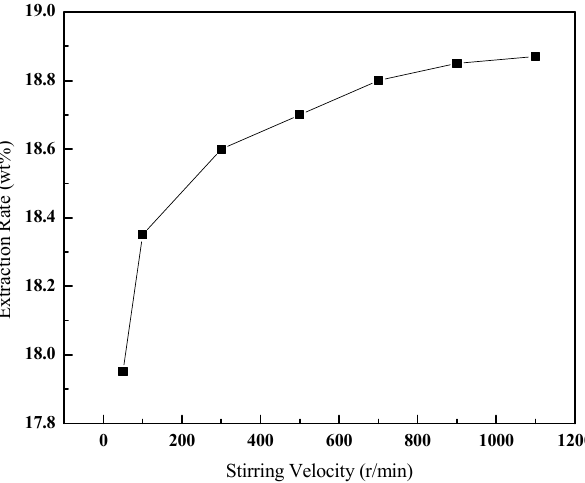
Figure 5. Effect of the stirring velocity on the extraction rate of Figure 5. E ff ect of the stirring velocity on the extraction rate of bitumen. Figure 5. E ff ect of the stirring velocity on the extraction rate of bitumen.